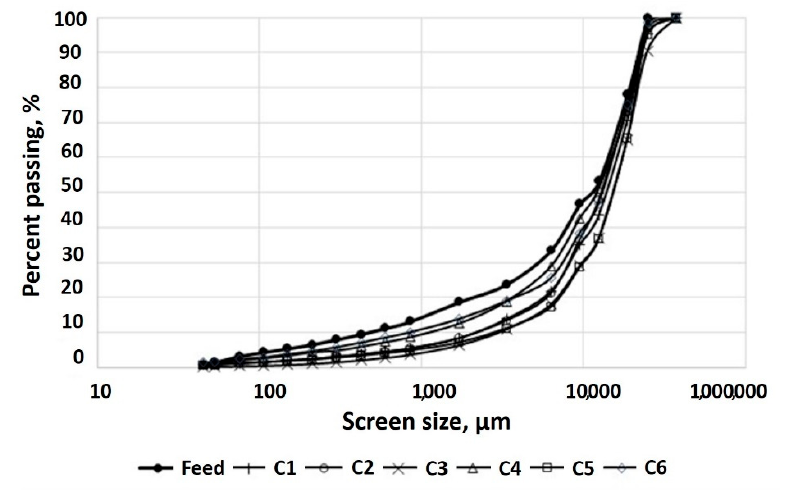
Figure 6. Granulometric analysis of the feed and residues in the leaching columns.